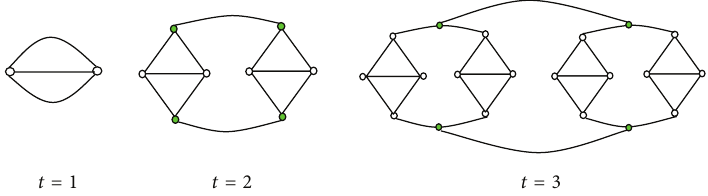
Figure 1: Construction of the deterministic 3-regular network 𝑈 𝑡 , showing three steps of the iterative